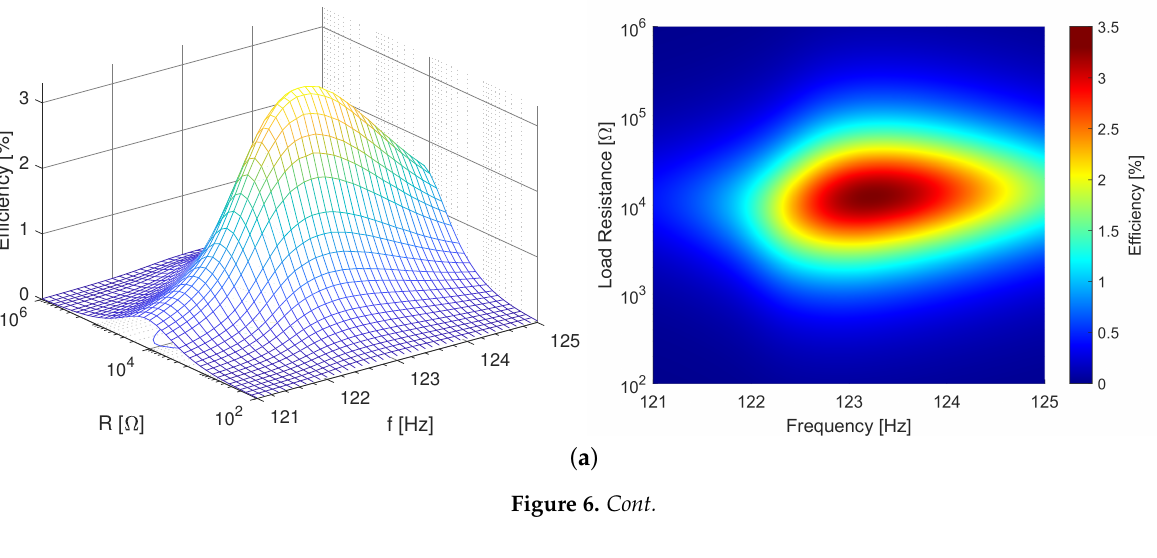
( c ) and 2 g ( d ). rms rms